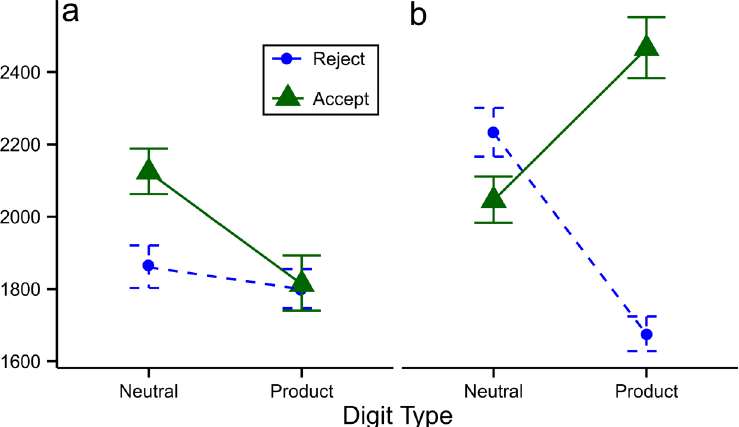
Figure 5. Mean reaction times by condition in the Sentence Verification task separated by Prompt Type and into (a) Implicative and (b) Non-Implicative trials. Error bars represent one standard error of the mean.